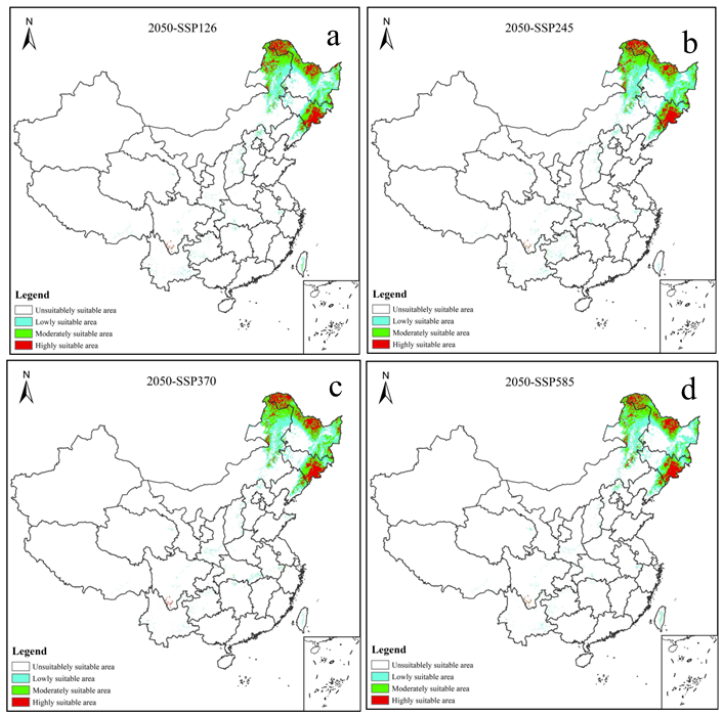
Figure 5. Prediction of the potential distribution of V. uliginosum in China under future climatic scenarios (2050s). ( a ) Potential distribution of V. uliginosum in China under the 2050s-SSP1-2.6 scenario; ( b ) Potential distribution of V. uliginosum in China under the 2050s-SSP2-4.5 scenario; ( c ) Potential distribution of V. uliginosum in China under the 2050s-SSP3-7.0 scenario; ( d ) Potential distribution of V. uliginosum in China under the 2050s-SSP5-8.5 scenario.